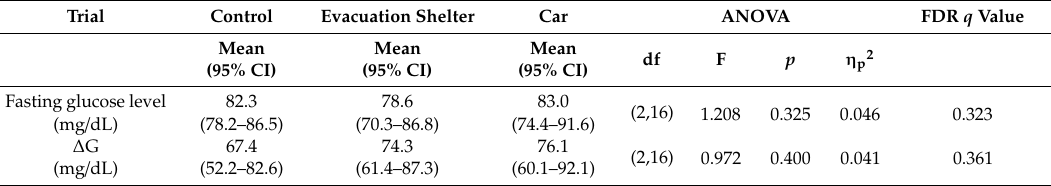
Table 4. Results of glucose indices ( n =